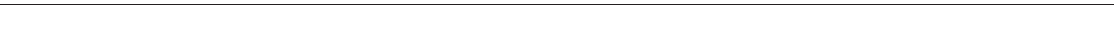
Fig. 4 PIXR in fl uences bio fi lm-like structures in tick guts. Guts of nymphal ticks fed for 48 h on ovalbumin-immunized (Ovalbumin) or rPIXR-immunized (PIXR) mice assessed by transmission electron microscopy (TEM): a pictorial depiction of the gut section; Lumen, L; Epithelium, E; B . burgdorferi , Bb; gut microbiota, M; and Villi, V. Arrows indicate B . burgdorferi that have breached the PM and are lying against the epithelial cells. A region similar to that represented in the boxed area is shown in the TEM image in b . Decreased numbers of B . burgdorferi in the gut lumen and a more diffuse peritrophic matrix (PM) in the rPIXR-immunized or ds pixr-injected guts compared to the dense PM in the Ovalbumin-immunized or ds gfp injected guts. Bottom panel in each column represents a focused view for clarity. Scale bars, 2 and 1 μ m (top and bottom). c Quanti fi cation of the spirochete numbers in gut sections ( n = 6 group). Scanning electron microscopy of 48 h-fed guts: d shown at low magni fi cation (LM) of ~×500 is a representative gut slit open to reveal the inside of the gut (I), outside of the gut (O) and epithelium (E) lining the gut. Scale bar, 50 μ m and regions similar to the boxed area is shown at a magni fi cation ~×5000 in e . The inside of the gut showing sparse bio fi lms-like structures (BF) in ticks fed on ovalbumin-immunized mice (anti-Ova) or in ds gfp-injected guts (ds gfp) compared to the dense and matte-like bio fi lm in ticks fed on rPIXR-immunized mice (anti-PIXR) or ds pixr RNA-injected guts (ds pixr). Bio fi lm-like structures in PIXR-abrogated ticks fed on buffer-injected mice (buffer) are decreased in ticks fed on gentamicin-injected mice (Gentamicin); scale bar, 5 μ m. f scanning electron microscopy of unfed guts: a representative gut slit open to reveal the inside of the gut (I), outside of the gut (O) and epithelium (E) (LM ~×480) and the inside of the gut showing fi nger-like projections at a magni fi cation of